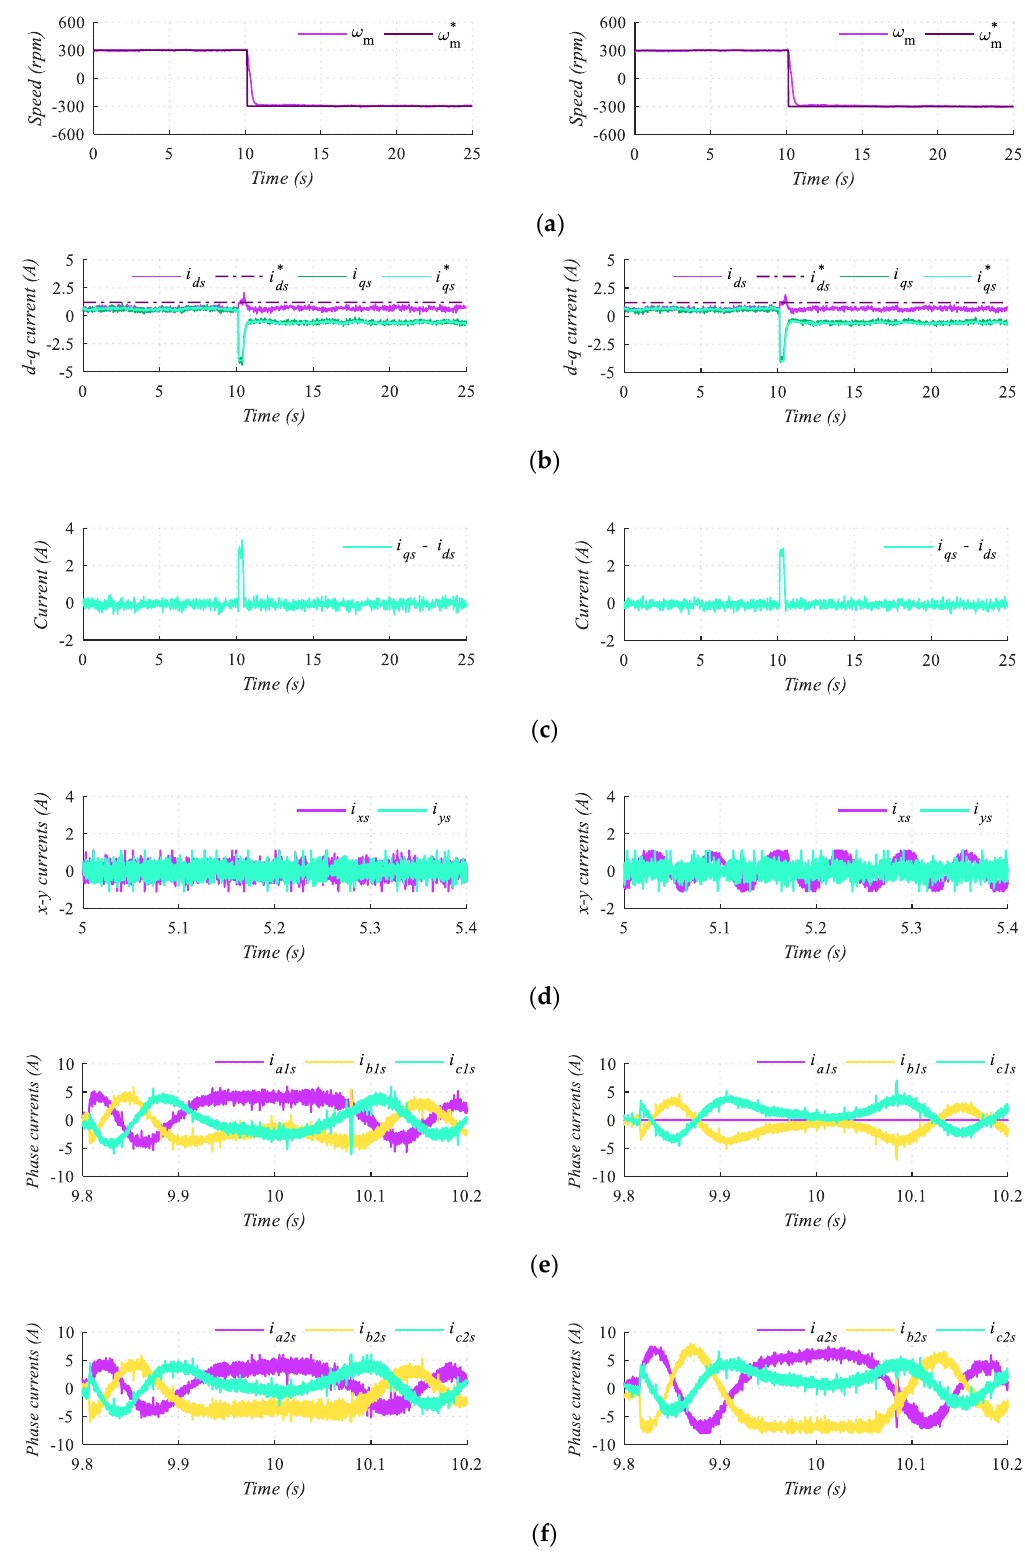
Figure 10. Reversal speed test in pre (left column) and post-fault situation (rigth column). From top to bottom: ( a ) Motor speed; ( b ) 𝑑 - 𝑞 currents; ( c ) difference between 𝑞 - and 𝑑 - currents; ( d ) zoom 𝑥 - 𝑦 currents; ( e ) zoom of set 1 of phase currents; and ( f ) zoom of set 2 of phase currents.